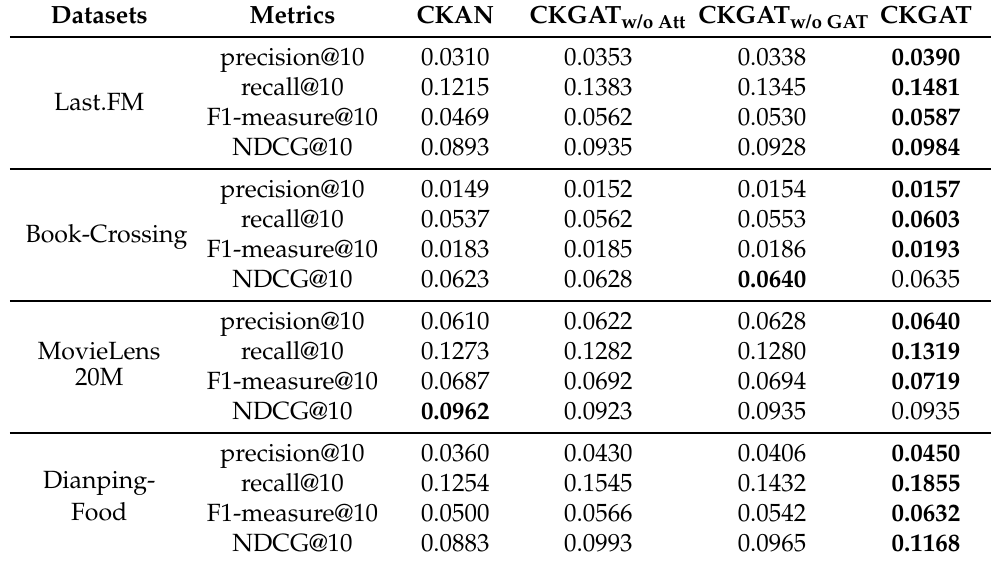
Table 2. Recommendation accuracy of CKAN, CKGAT, and the two variants on the four datasets.